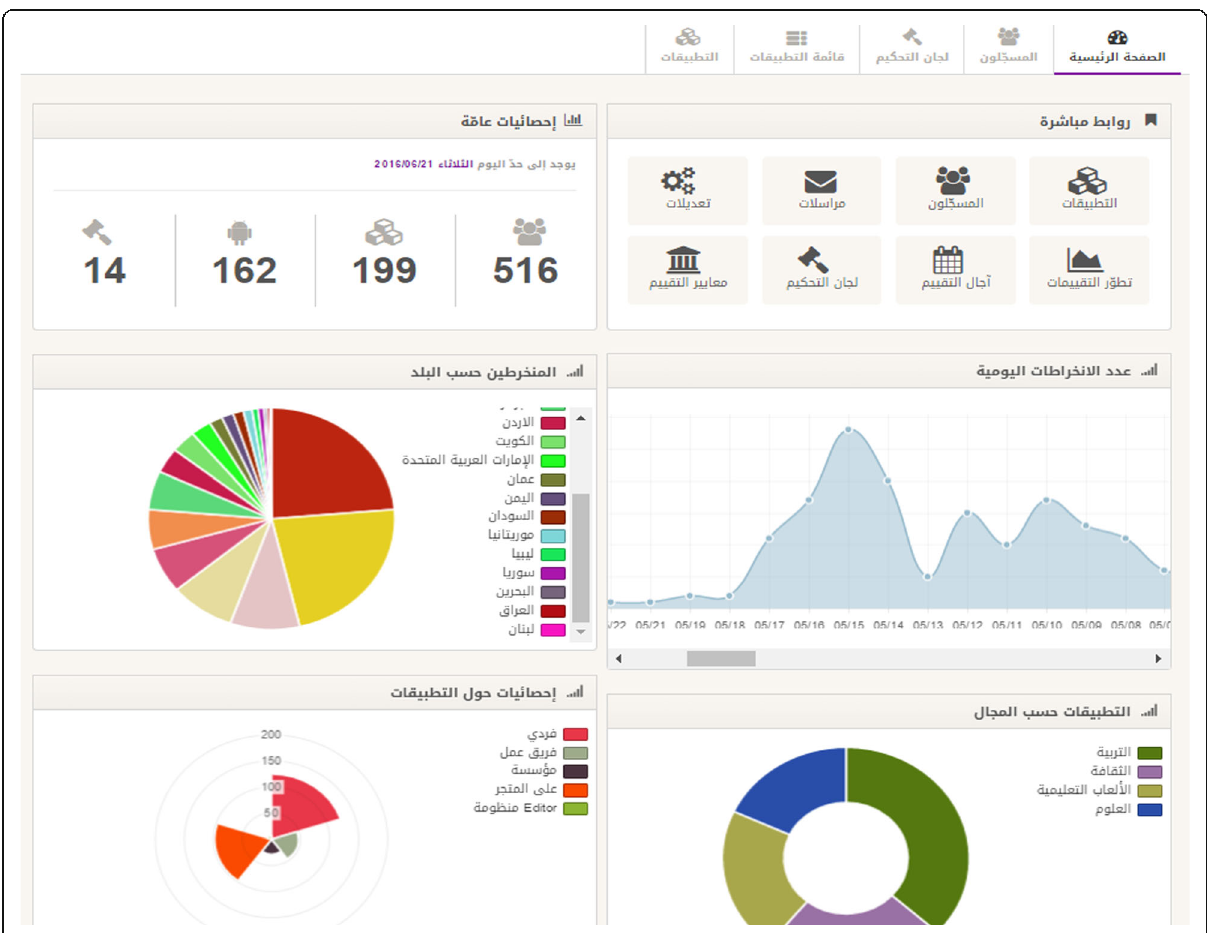
Fig. 12 ALECSO APPs Award stats, Dubai 2016